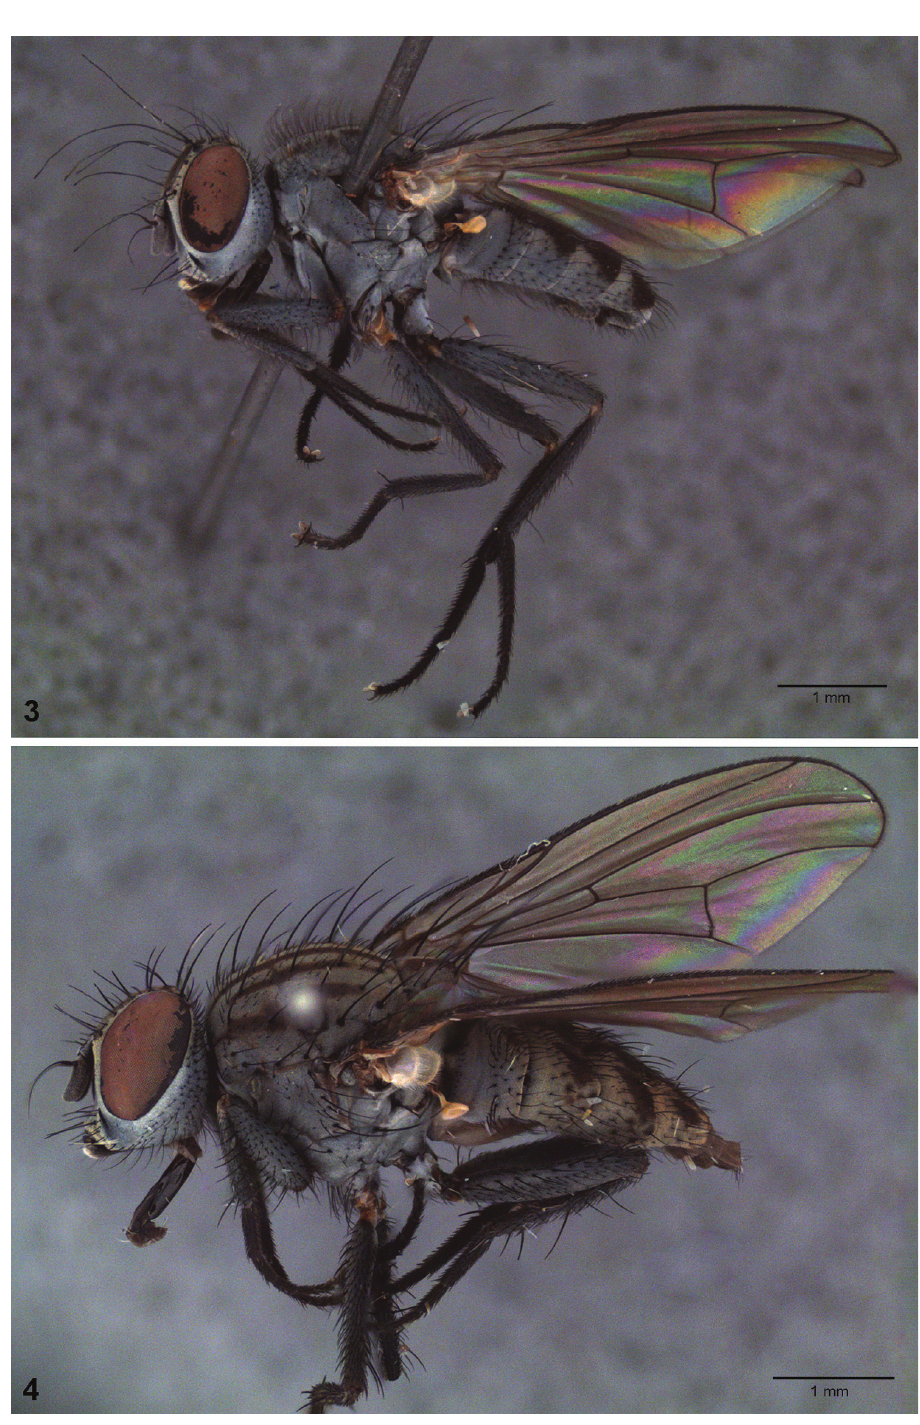
Figures 3, 4. Coenosia spp. habitus, lateral view 3 C. flagelliseta sp. nov. ♂ 4 C. flagelliseta sp. nov. ♀